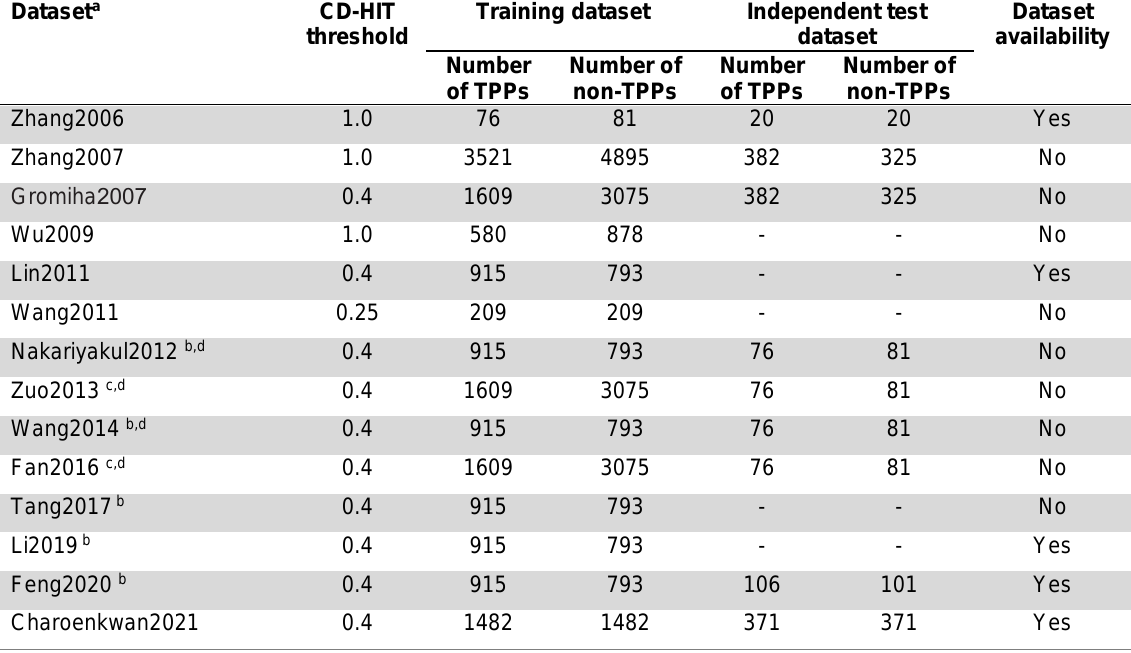
Table 2: A summary of the training and independent test datasets used for developing the existing TPP